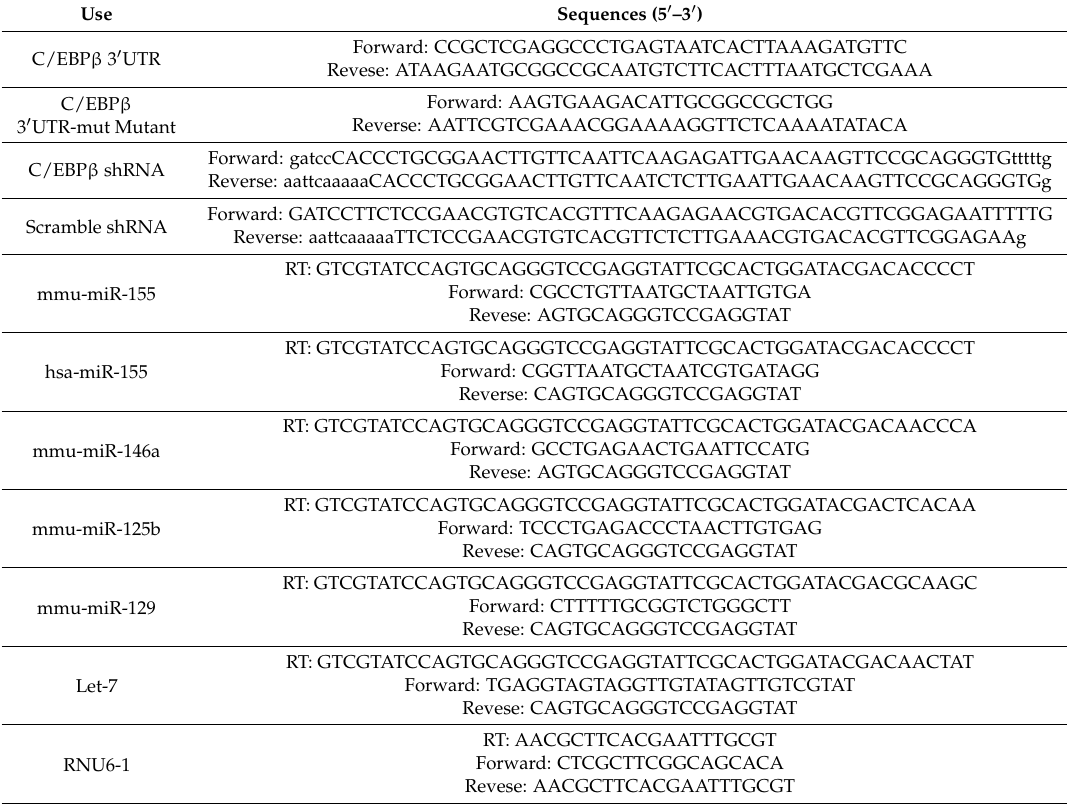
Table 1. Primers used in this